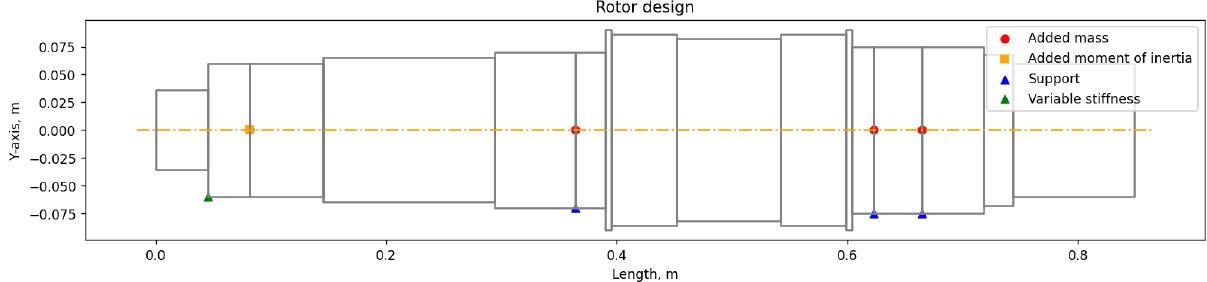
Figure 3. Calculation scheme of the finite element model.